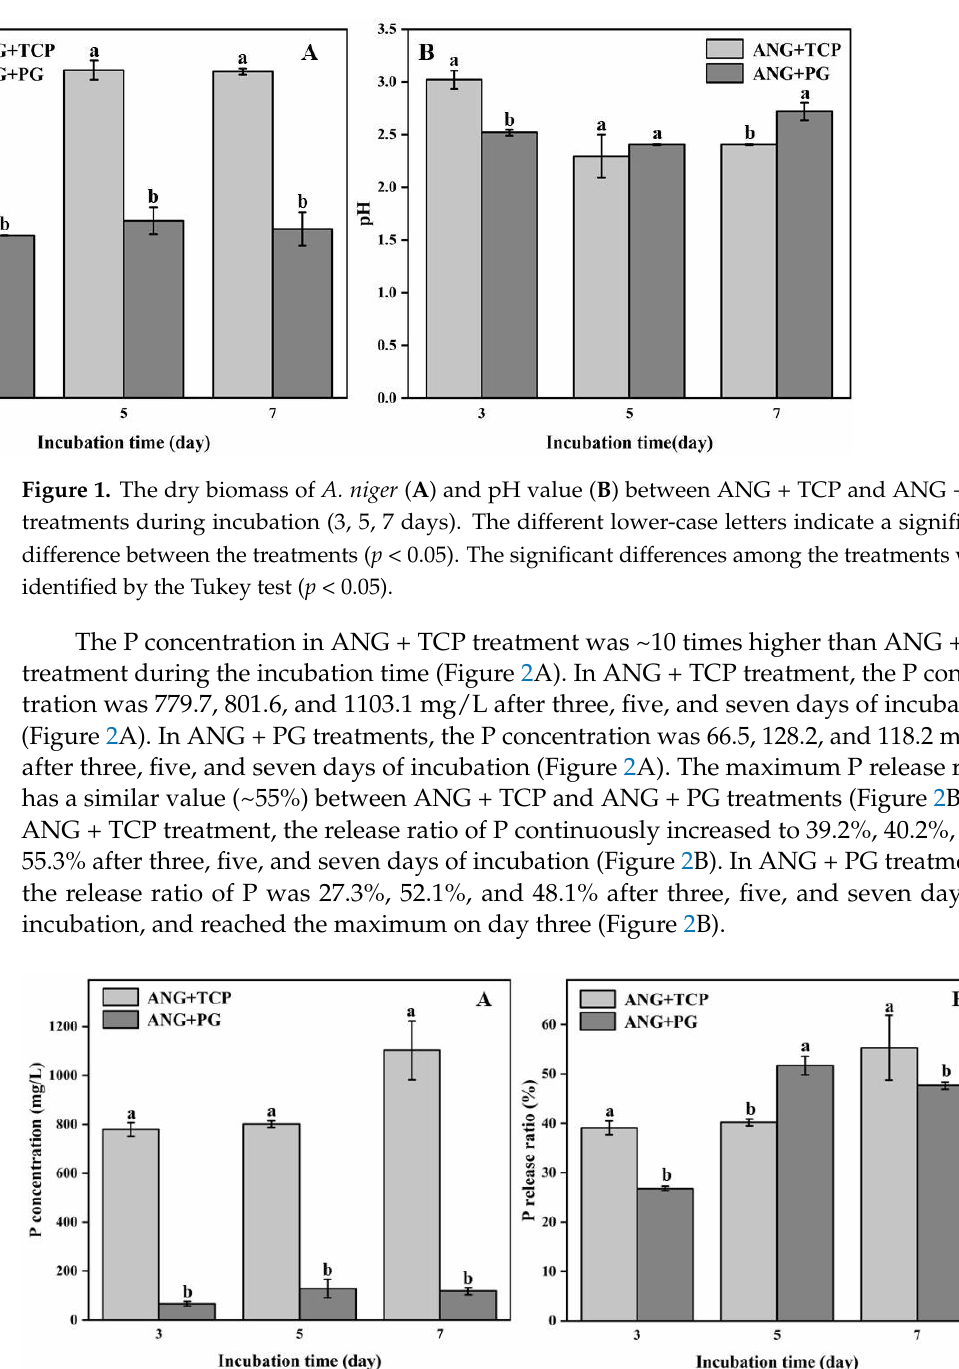
Figure 1. The dry biomass of A. niger ( A ) and pH value ( B ) between ANG + TCP and ANG + PG treatments during incubation (3, 5, 7 days). The different lower-case letters indicate a significant difference between the treatments ( p < 0.05). The significant differences among the treatments were identified by the Tukey test ( p < 0.05).